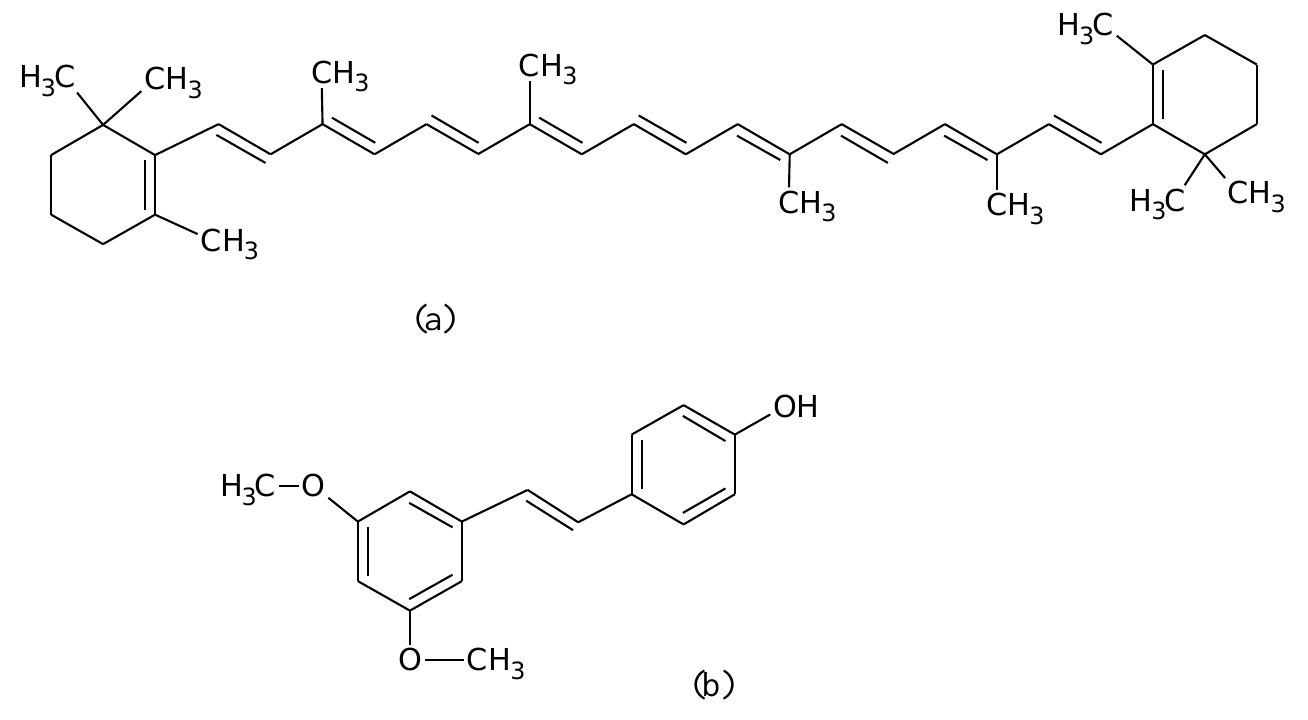
Figure 13. Chemical formula of ( a ) beta carotene and ( b ) pterostilbene. Pterostilbene (PTER) (Figure 13b) (trans-3,5-dimethoxy-4hydroxystilbene),